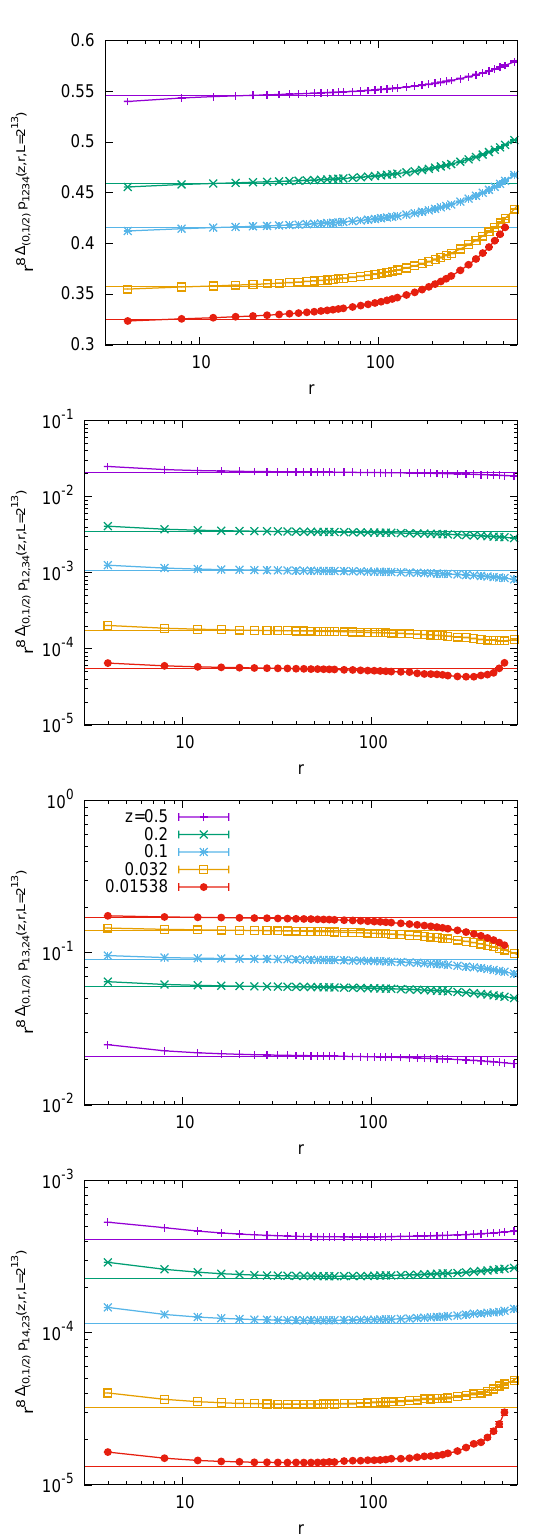
8 ∆ ( 0,1 ( z j r , L = 2 13 ) as functions of r for various cross-ratios z , in the ) p Figure A.6: r 2 X case Q = 2. Clockwise from the upper left panel, we display X = 1234, then 12,34, then 14,23, then